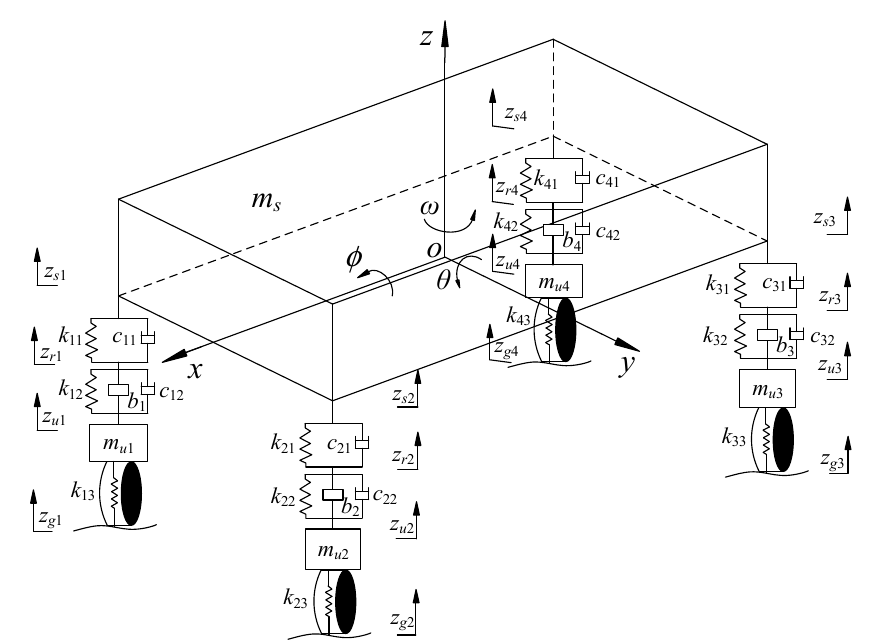
Figure 3. Vehicle model with ISD suspension.